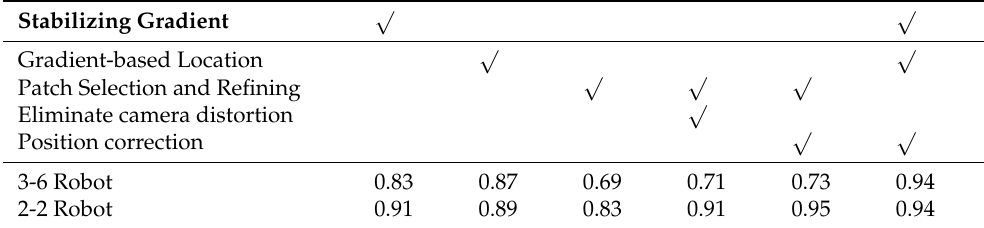
Table 4. Performance of HDPP algorithm on three data sets. We have summarized the test results of HDPP on three data sets. Each data set contains three rows of data, the first row is the minimum value, the second row is the maximum value, and the third row is the